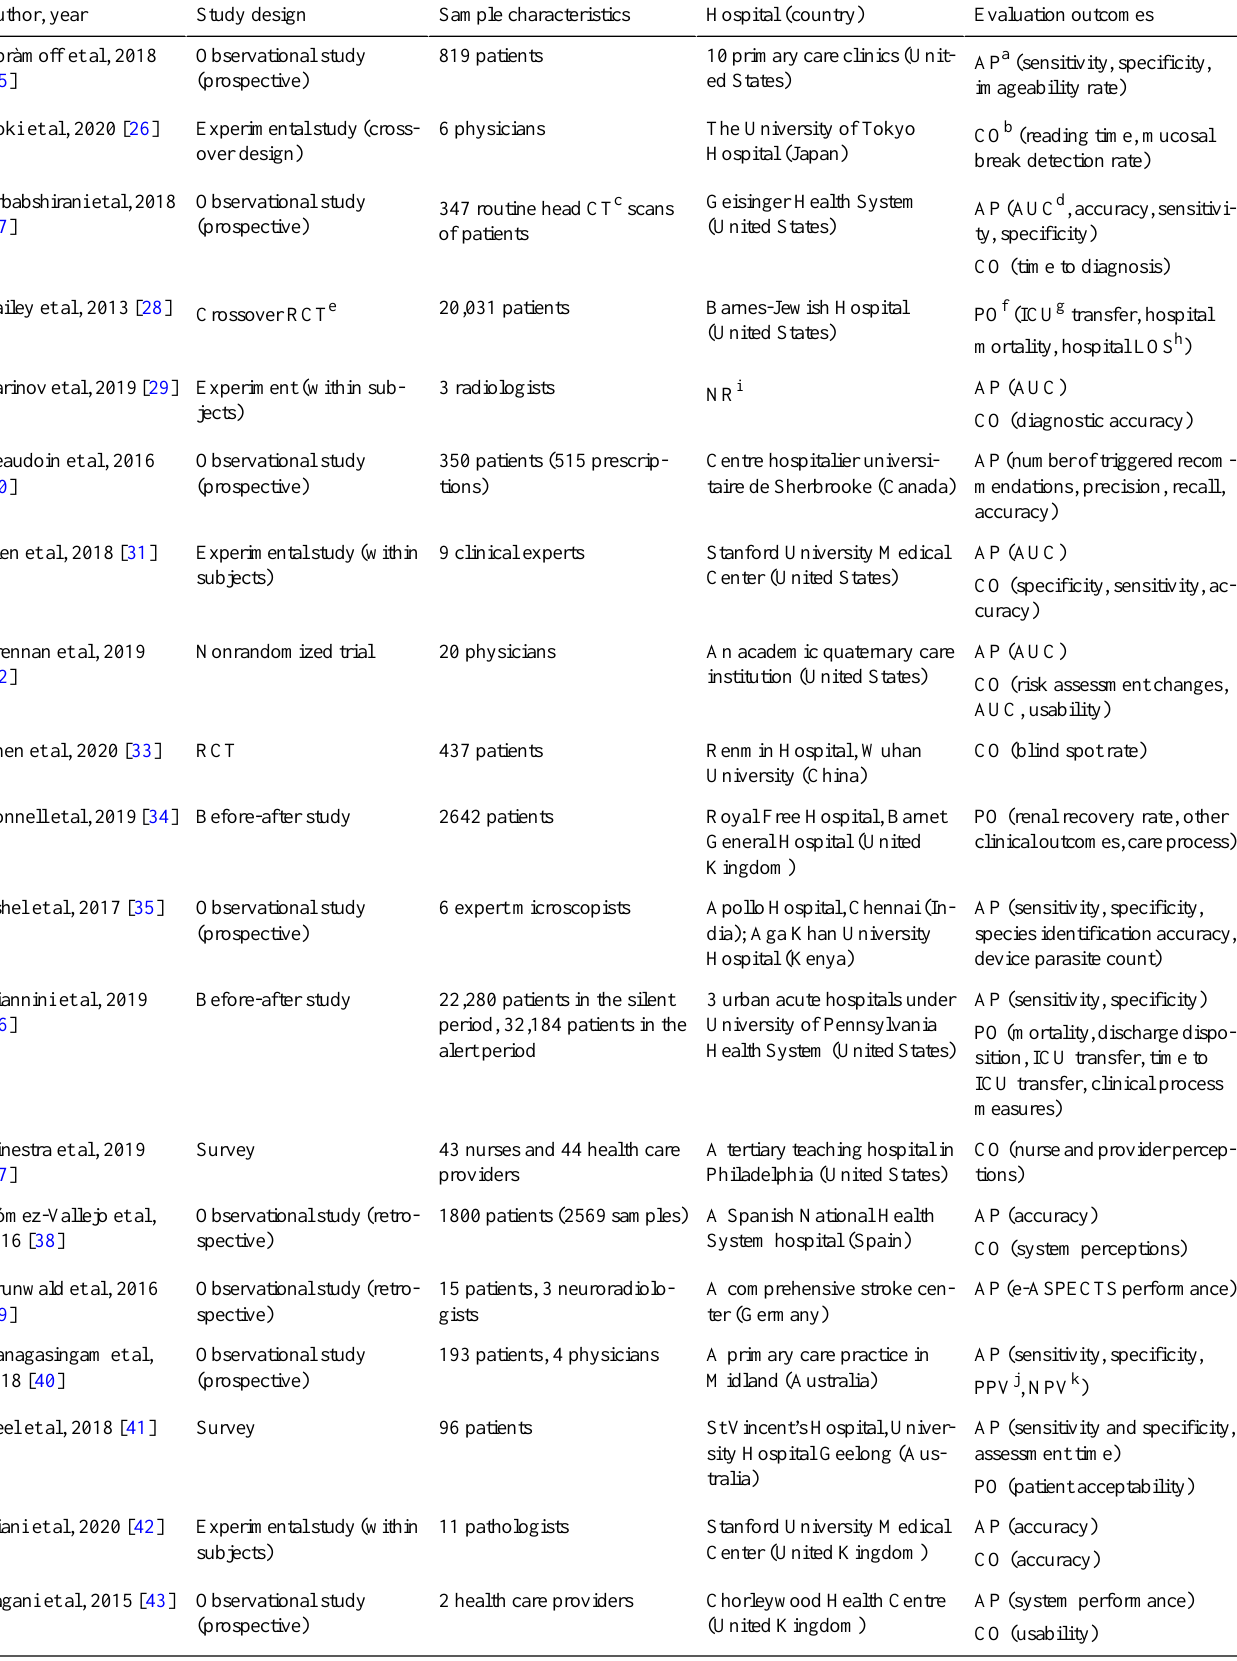
Table 1. Characteristics of the included